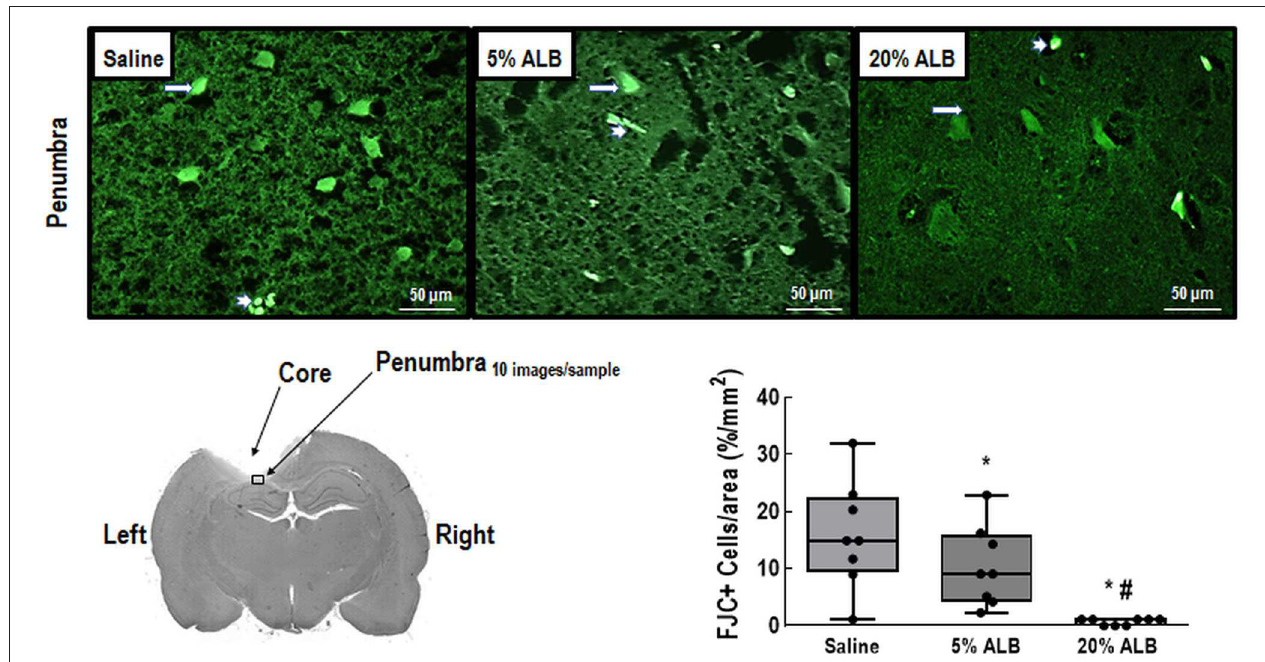
FIGURE 2 | Comparison of Fluoro-Jade C (FJC) staining between Saline (0.9% NaCl), 5% ALB (albumin), and 20% ALB groups. Long arrows point to FJC-positive cells, and short arrows, to vessels. Note representative diagram of a brain slice after ischemic brain injury, indicating the core and penumbra regions. Within the penumbra, a sample area from which FJC images were taken is highlighted. Comparisons among groups were performed by the Kruskal–Wallis test followed by Dunn’s test. * vs. Saline; # vs. 5% ALB. Significance accepted at p <